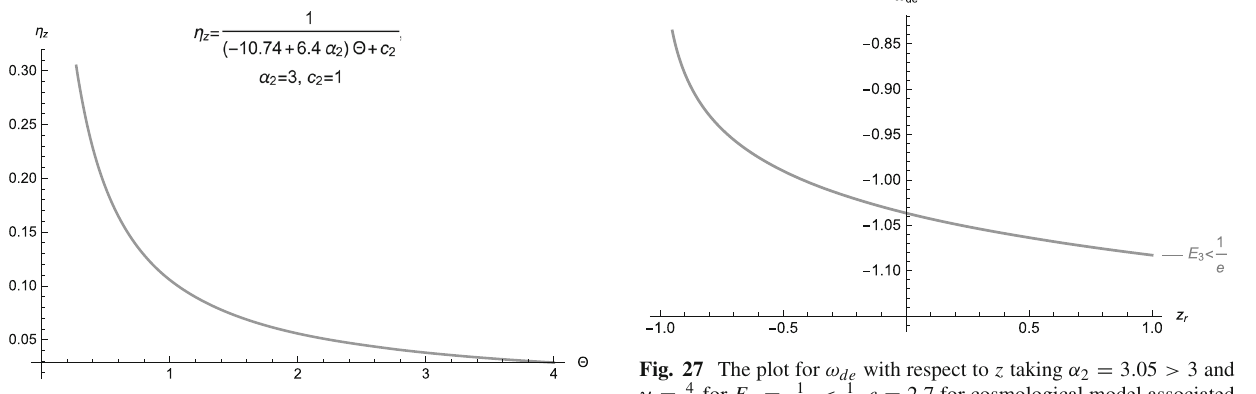
Fig. 25 The variation of η z with respect to (cid:16) for analysing stability at infinity for case III